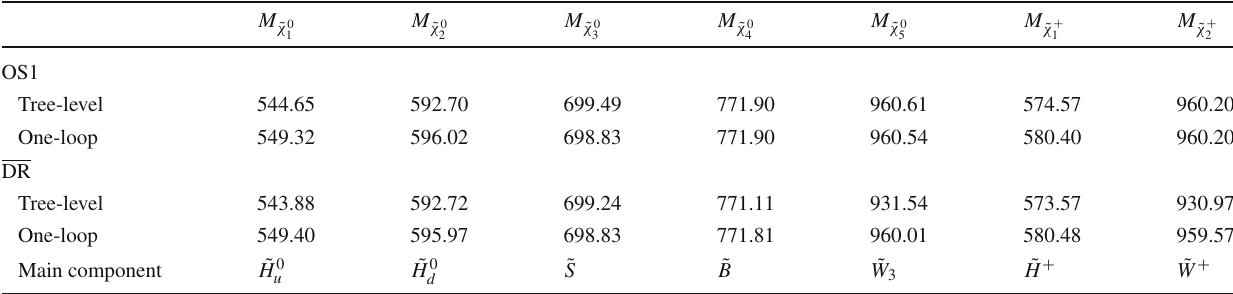
Table 3 The tree-level and one-loop corrected stop and sbottom masses in the DR and the OS scheme